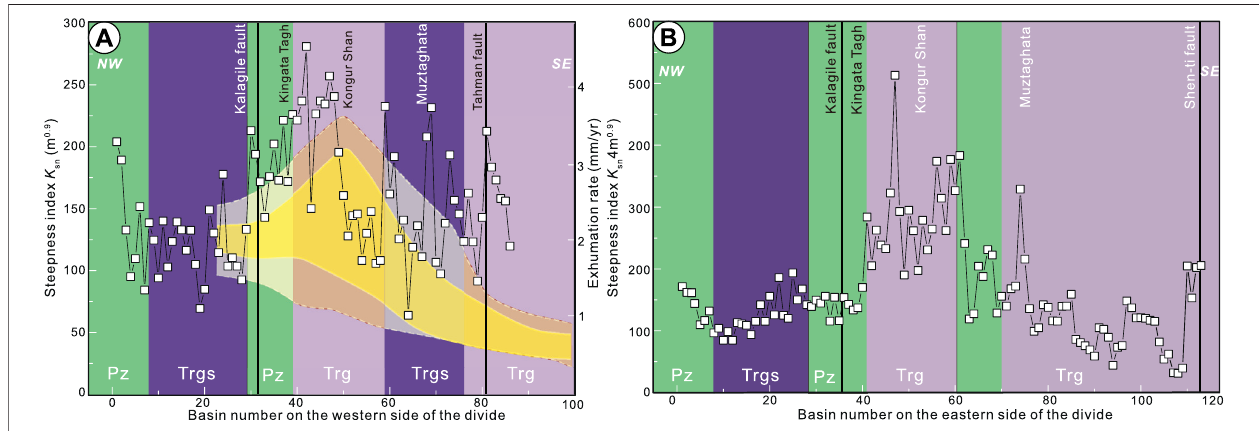
FIGURE 4 | Spatial distribution of Ksn values and footwall exhumation rates with respect to variable lithology on the western (A) and eastern (B) side of the divide along the KSF. Exhumation rates are from Thiede et al. (2013).